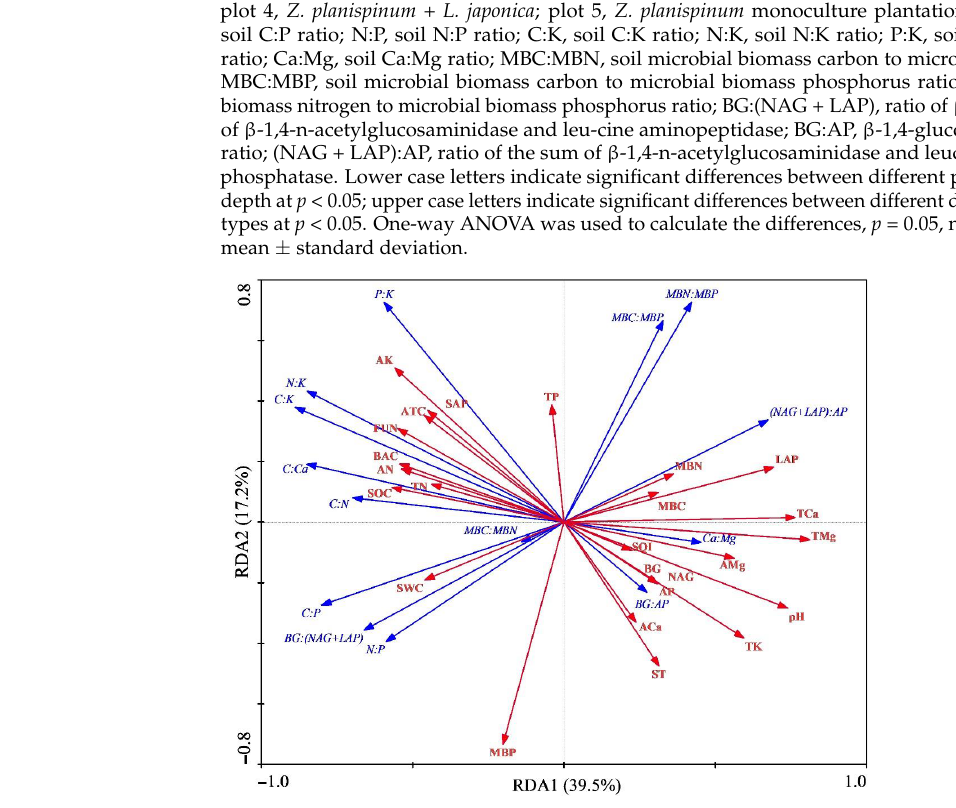
Figure 3. Two-dimensional sequence of the RDA analysis of soil quality and stoichiometry. ST, soil temperature; SWC, soil water content; SOC, soil organic carbon; TN, total nitrogen; TP, total phos-